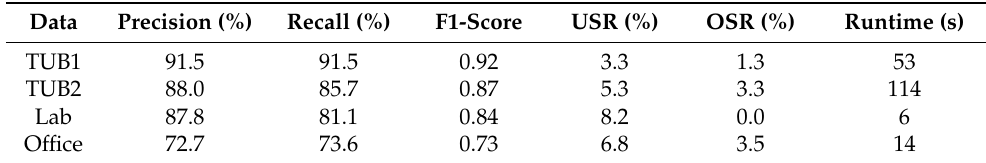
Figure 16. Plane-segmentation results for the Office dataset: ( a ) proposed method, ( b ) ground truth, ( c ) the main differences between ( a ) and ( b ), and ( d ) enlarged part. Table 2. Performances of the proposed method in the